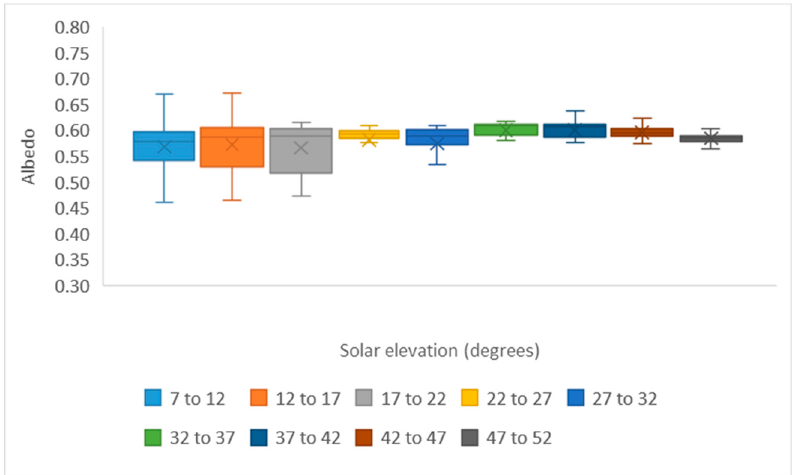
Figure 7. White pebbles’ clear (CL) sky condition for albedo variation against solar elevation. The eight ranges of solar elevation (degrees) are shown in the legend.